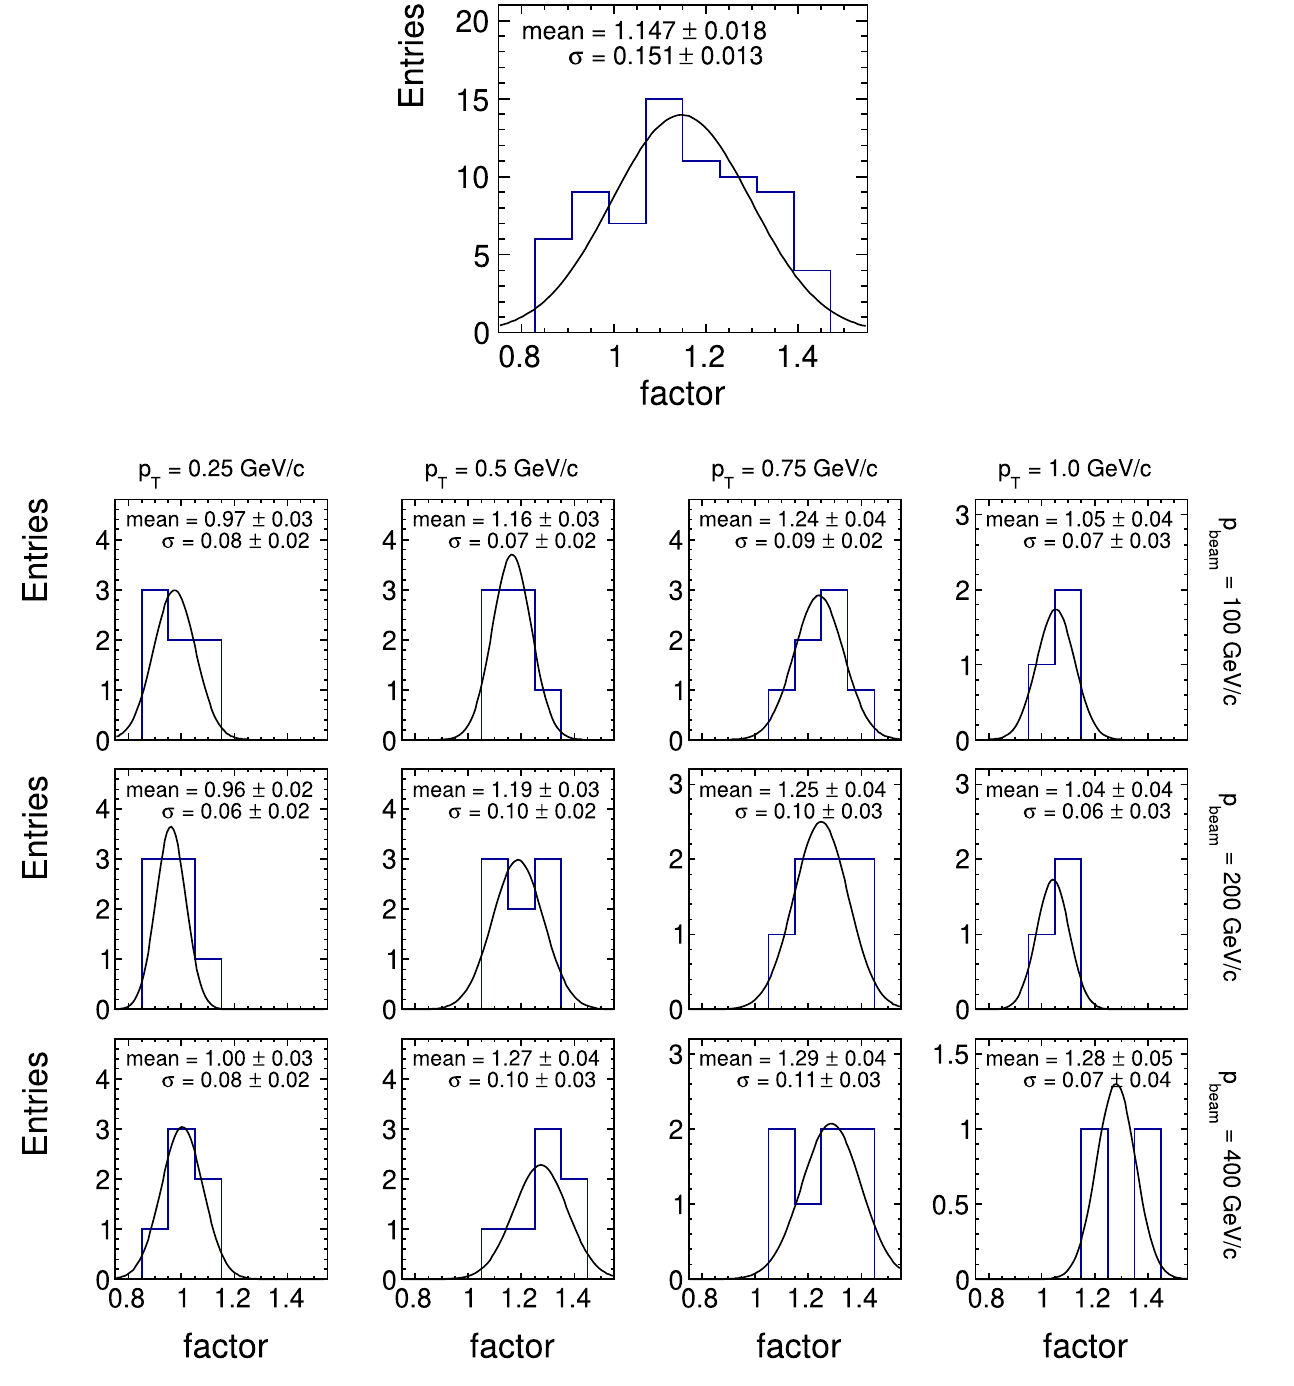
Fig. 52 Distributions of difference to the global interpolation for all data points and separately for the four p T values and the three beam momenta 9.12 The data of Antreasyan et al. [34] at 200, 300 and 400 GeV/c beam momentum. As the measurements were 400 GeV/c beam momentum done at a constant lab angle of 77 mrad, the correspond- ing rapidity values vary between 0.21 and − 0 . 13 . Figure 54 Only four data points of this celebrated experiment fall within shows the three data points at p T = 0.77 GeV/c with respect the p T range of this paper: at p T = 0.77 GeV/c for p lab = 200, to the reference 300 and 400 GeV/c, and at p T = 1.16 GeV/c only for